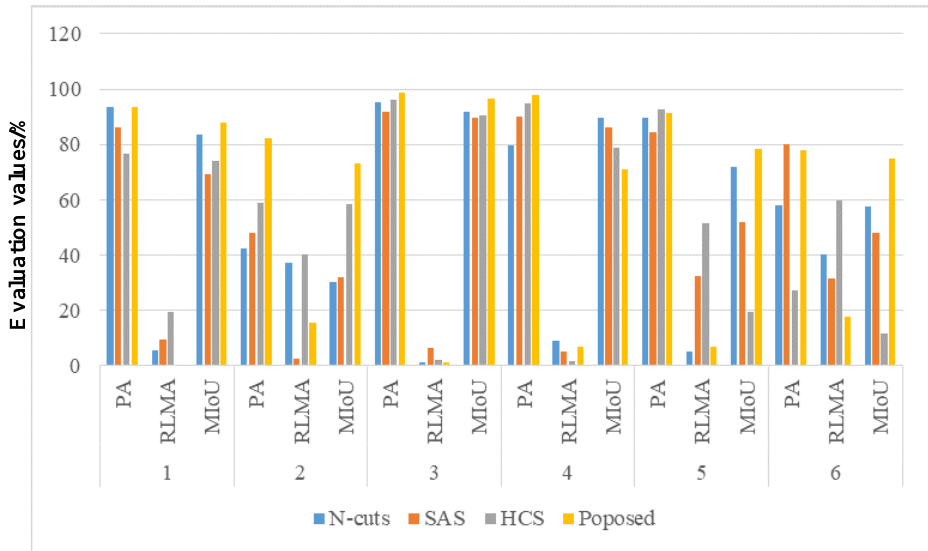
Figure 12. Comparative results of each algorithm. PA: Pixel accuracy ; RLMA: Relative limit measurement accuracy ; MIoU: Mean intersection over the union .